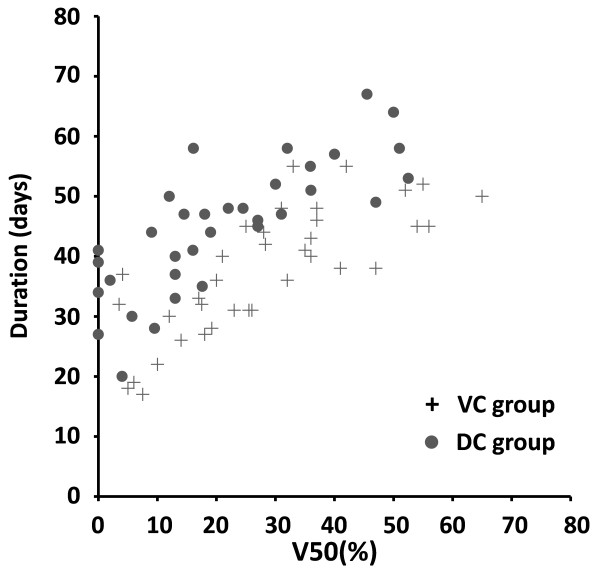
AE duration versus V50 of esophagus for patients in VC group (+) and DC group (). Abbreviations: AE = acute esophagitis; V50 = relative esophageal volume for radiation dose ≥ 50 Gy; VC = Vinorelbine/Cisplatin; DC = Docetaxel/Cisplatin.